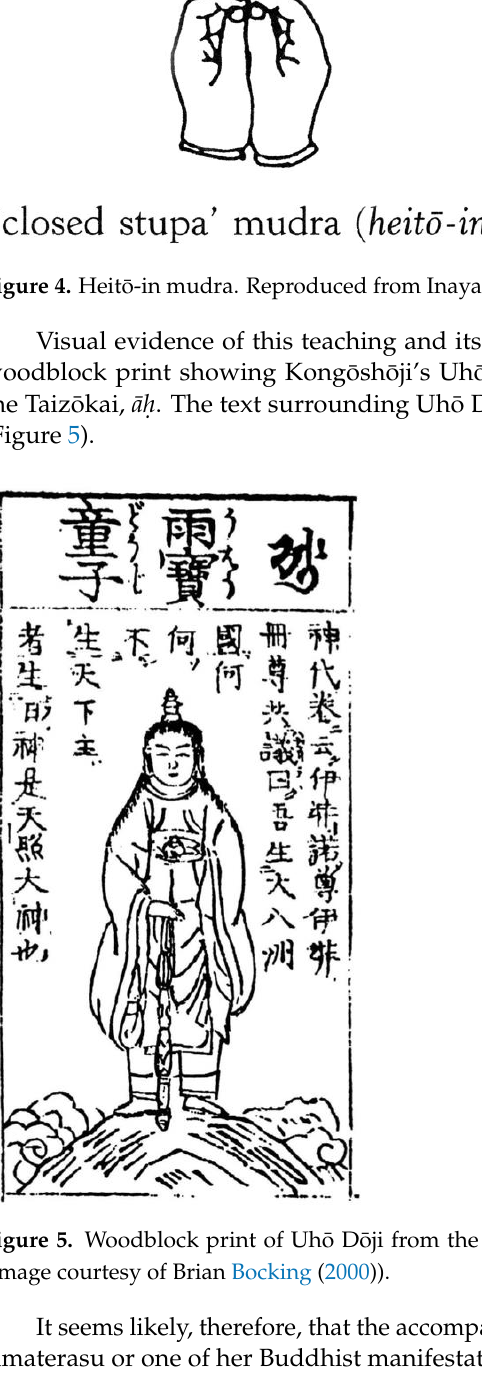
Figure 5. Woodblock print of Uhō Dōji from the Sanjūbanjin (Thirty Deities) series. Edo period. (Image courtesy of Brian Bocking (2000)).